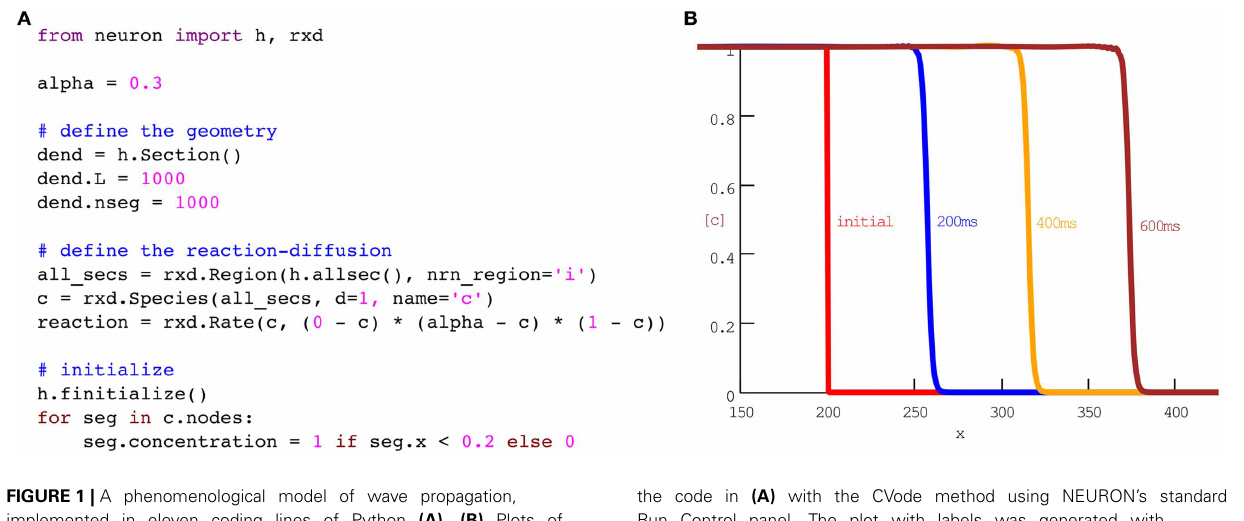
FIGURE 1 | A phenomenological model of wave propagation, implemented in eleven coding lines of Python (A) . (B) Plots of concentration vs space at times as indicated. No additional code is needed for the run or plotting; this panel is the result of running